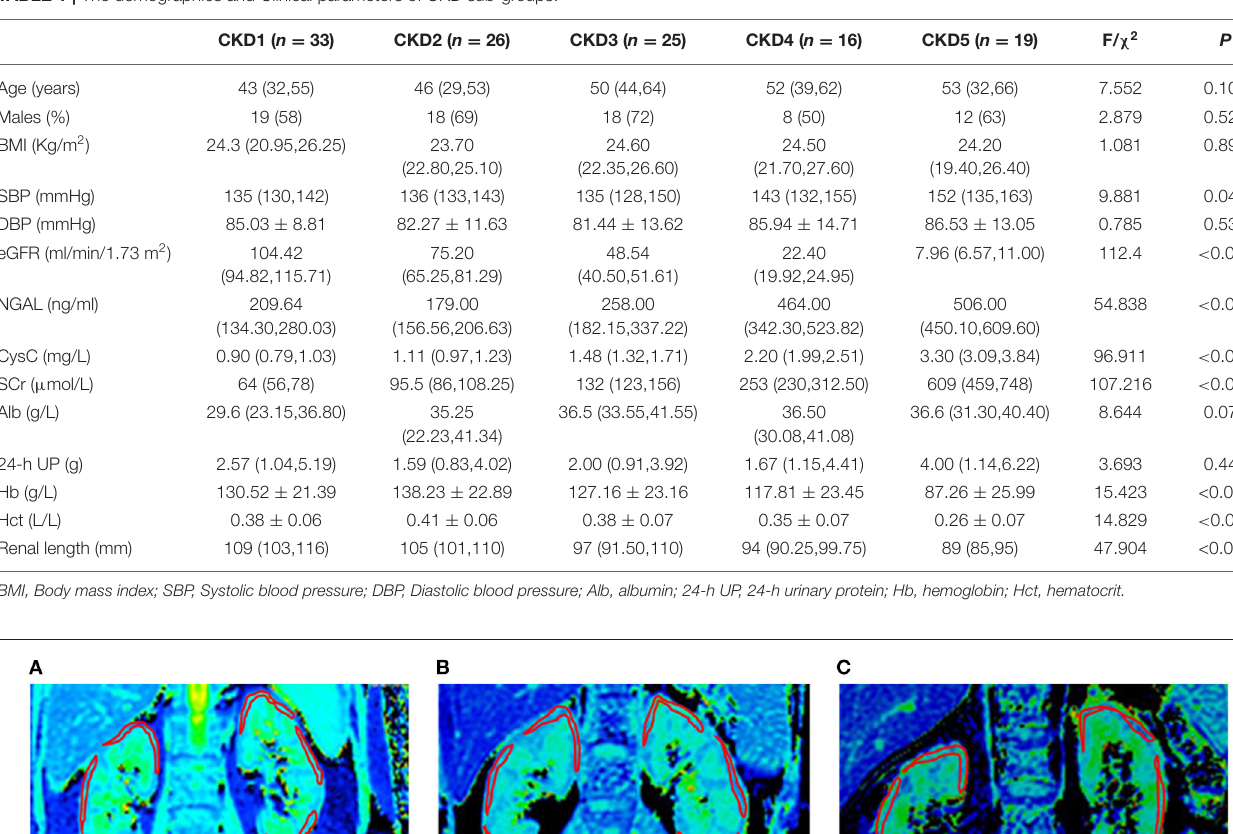
TABLE 1 | The demographics and Clinical parameters of CKD sub-groups.